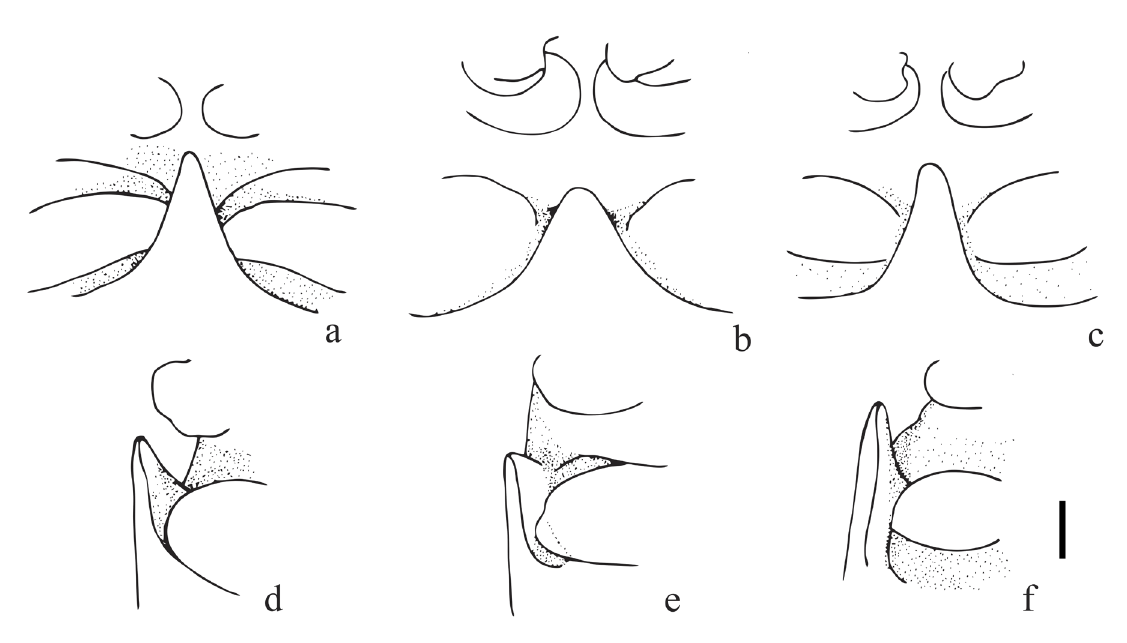
Fig. 8. Patterns of mesoventral process. a, d . Oplognathus kirbii MacLeay, 1819 (MZUSP).